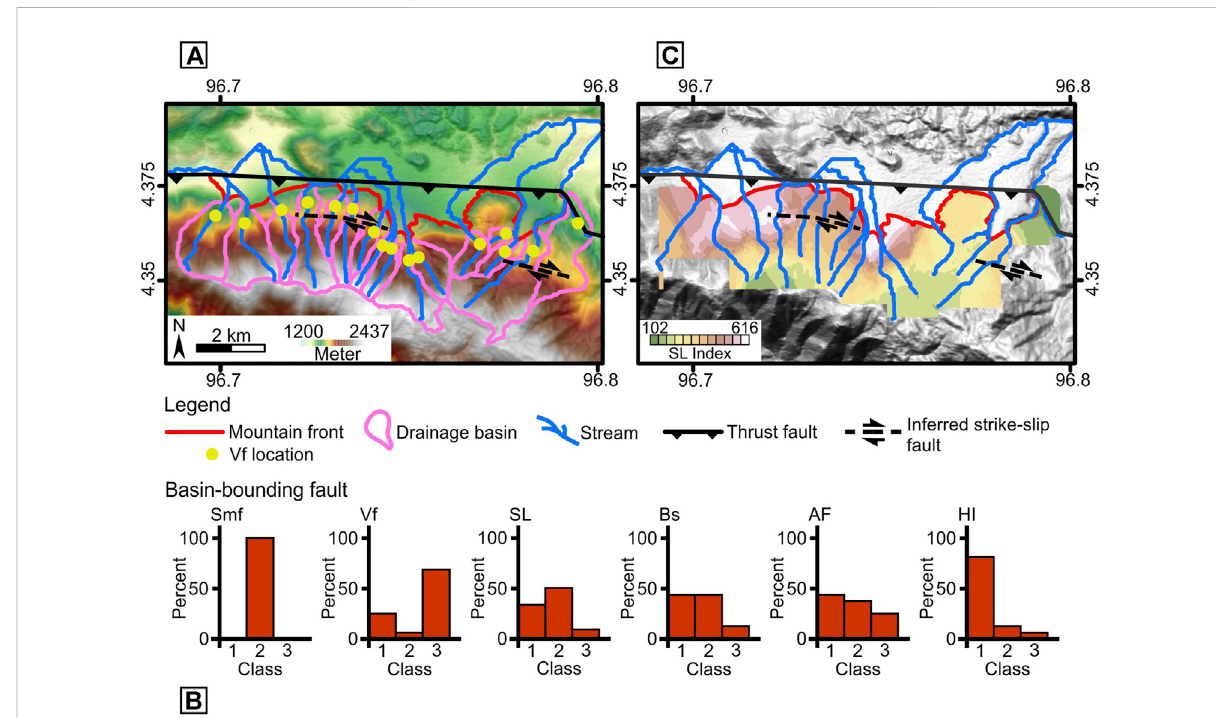
FIGURE 10 The Jagong Jeget Basin: (A) the mountain fronts, faults, and drainage basins, (B) classi fi cation of geomorphic indices, and (C) stream length- gradient